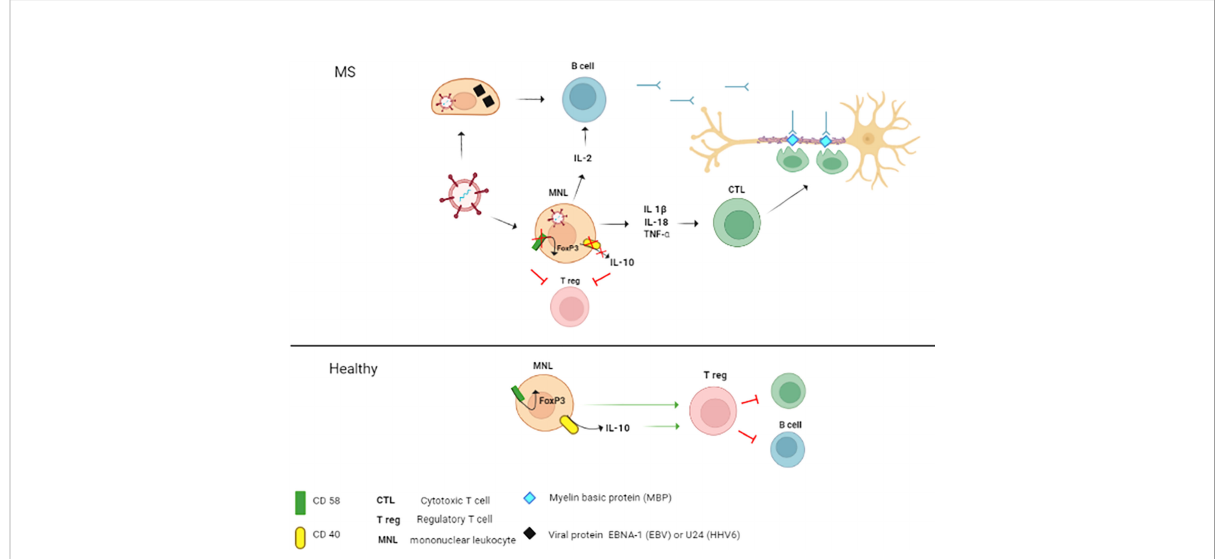
FIGURE 6 The mechanisms of the contribution of herpesvirus infection combined with CD58 and CD40 SNPs ’ to MS pathogenesis. In MS, combined pathogenic effect of herpesviruses and SNPs in CD58 and CD40 could be explained by three potential mechanisms: 1. Molecular mimicry; 2. Activation and maintenance of in fl ammation; 3. Reduction of regulatory capacity of Tregs. 1. B cells primed with herpesvirus proteins (EBV nuclear antigen 1 (EBNA-1 and UL24) could produce antibody cross-reacting with myelin basic protein (MBP) epitopes (122,123). These antibodies could cross the blood-brain barrier (BBB) and target the axon myelin sheath. Also, cross-reactive cytotoxic T lymphocytes (CTL) could be generated and damage the axon myelin. 2. Herpesvirus infection could contribute to the pathogenesis of MS by activation